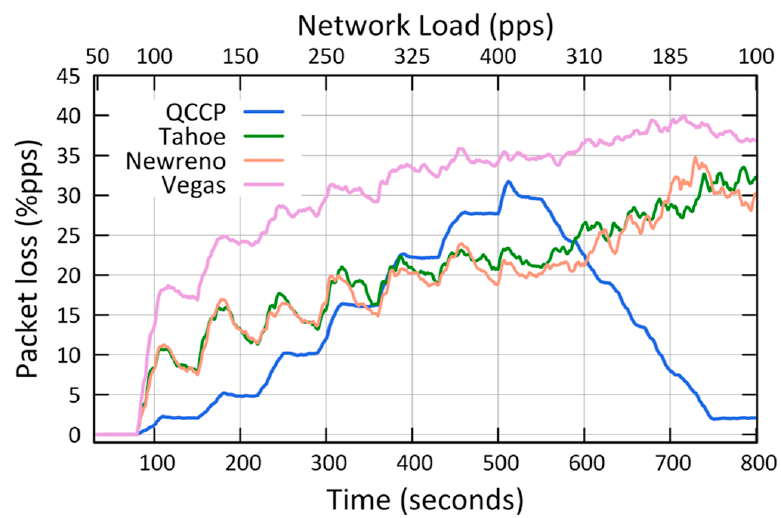
Figure 11. Comparison of average packet loss (P L ).